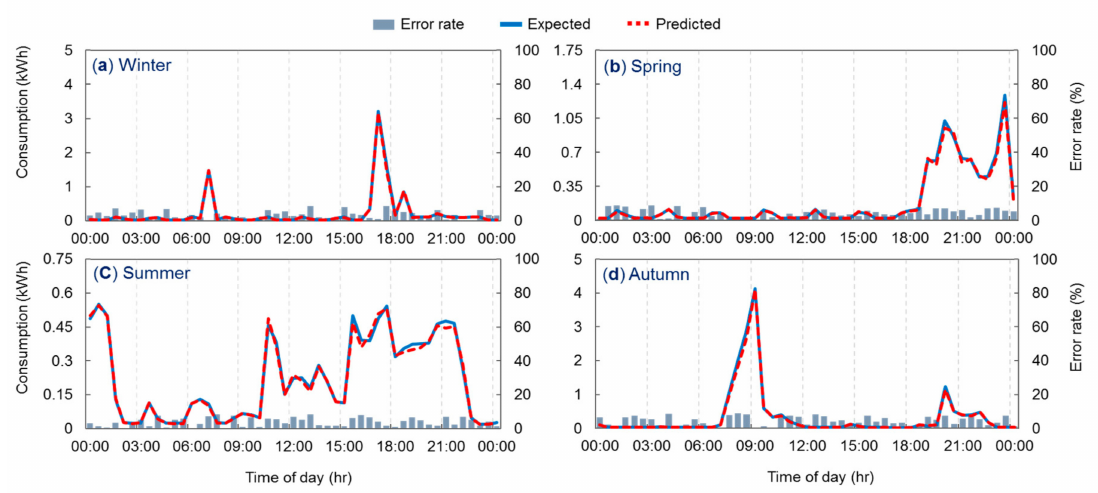
Figure 5. Comparison between the actual and predicted electricity consumption for the training results of ANN1 for a typical day in four seasons: ( a ) winter; ( b ) spring; ( c ) summer; and ( d ) autumn.